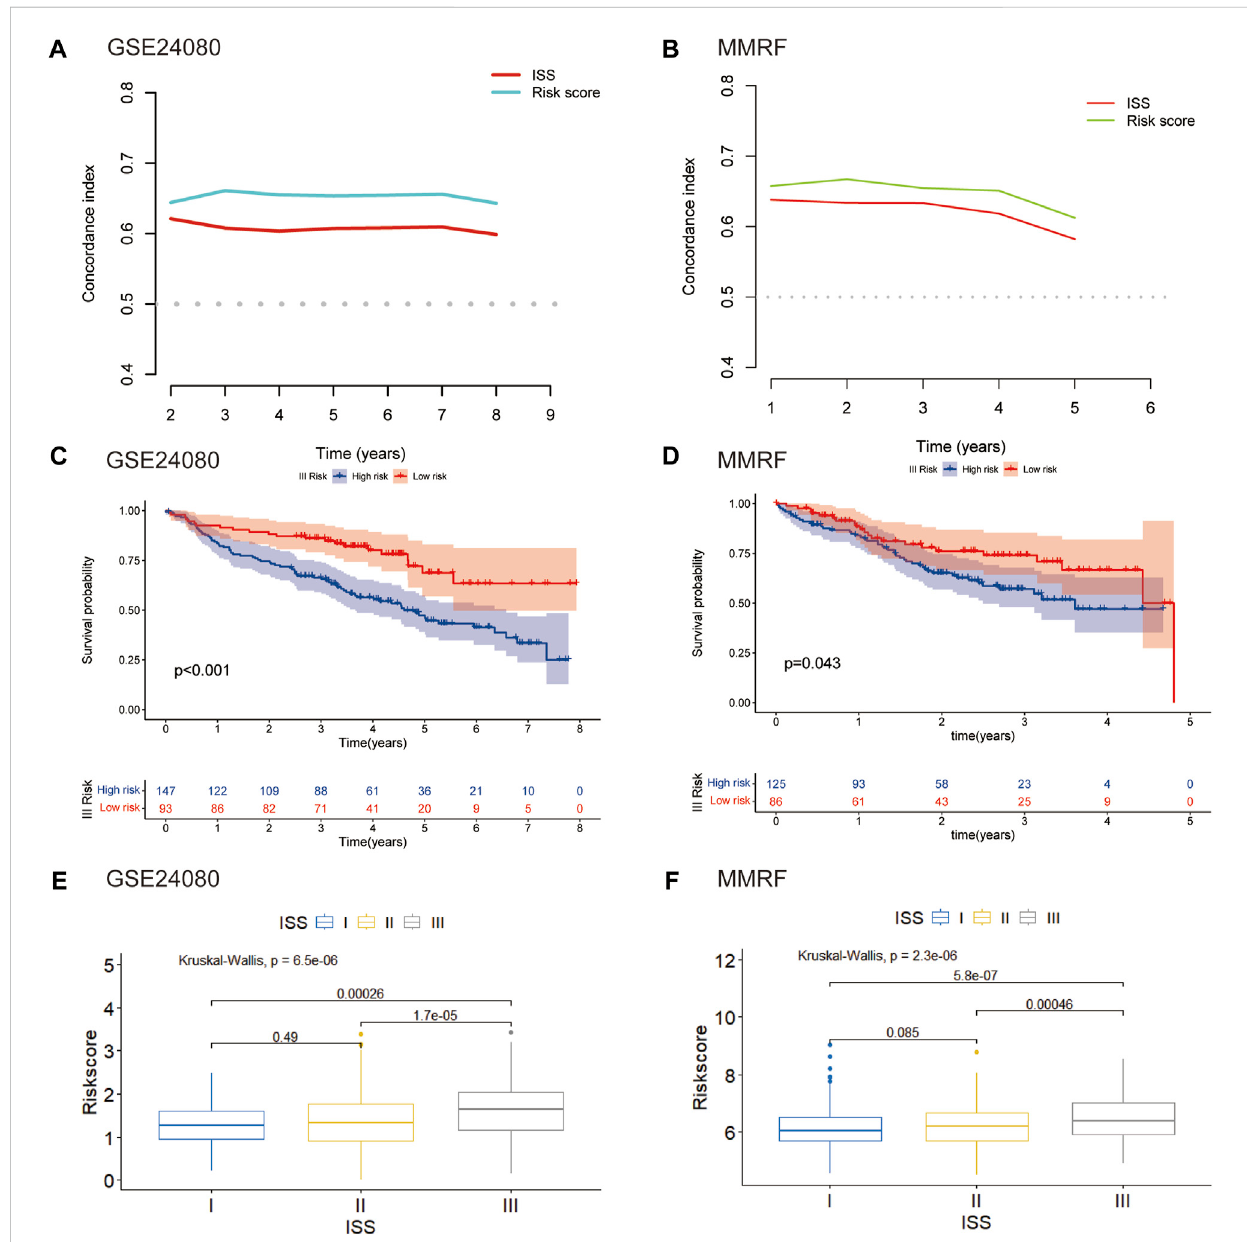
FIGURE 7 Validationoftheeight-generiskscoremodelinISS (A) TheC-indexofourriskmodelandISSinGSE24080. (B) TheC-indexofourriskmodelandISS in MMRF. (C) Kaplan – Meier curves of MM patients in stage III of ISS in GSE24080 ( p < 0.001). (D) Kaplan – Meier curves of MM patients in stage III of ISS in MMRFcohort( p =0.043). (E) BoxplotshowedthedifferenceinriskscorefordifferentstagesinGSE24080( p < 0.001). (F) Boxplotshowedthedifferencein risk scores for different stages in MMRF ( p <